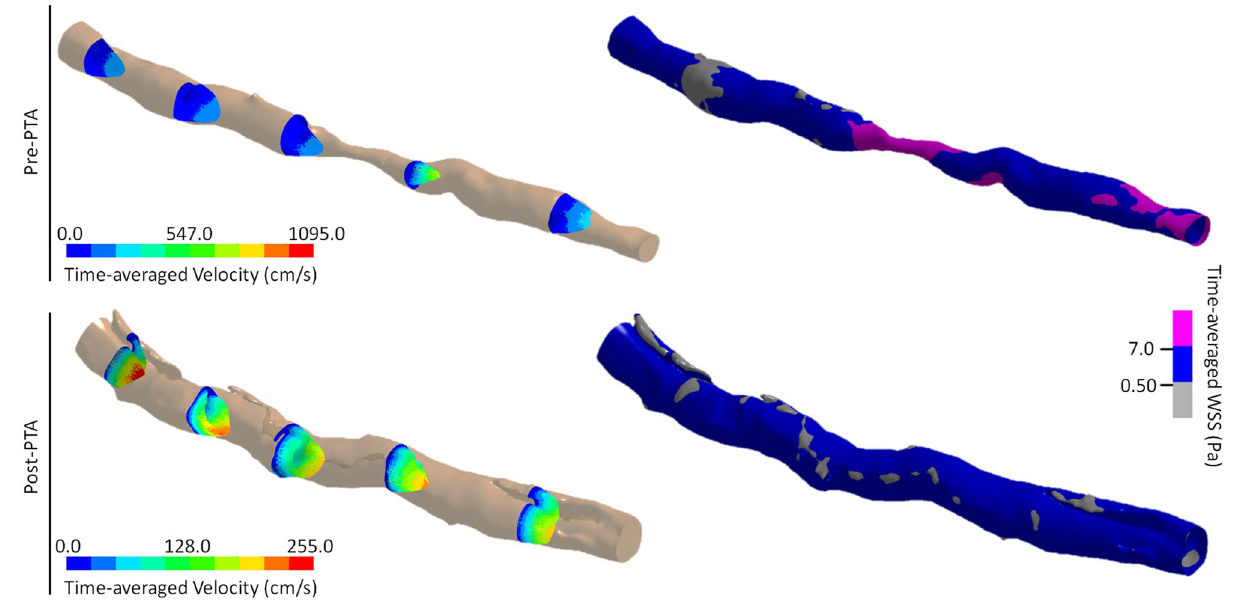
Figure 3. The development of time-averaged flow velocity and distribution of time-averaged Wall Shear Stress (TAWSS) in an artery (P3) before and after PTA. Prior to treatment, the maximum velocity is located at the lumen narrowing and the areas affected by low TAWSS are only located proximal to this section. The presence of low (grey) and high (magenta) TAWSS at this time-point is mostly related with localized diameter changes and skewness of the velocity profile, which occurs due to the natural tortuosity of the artery. Following PTA, there is a significant increase in the lumen diameter and multiple dissections can be observed along the length of the artery. The low velocity at these regions directly affects the WSS distribution, which shows that the areas affected by low TAWSS (grey) are mainly localized at the surfaces generated by dissections. (Generated by